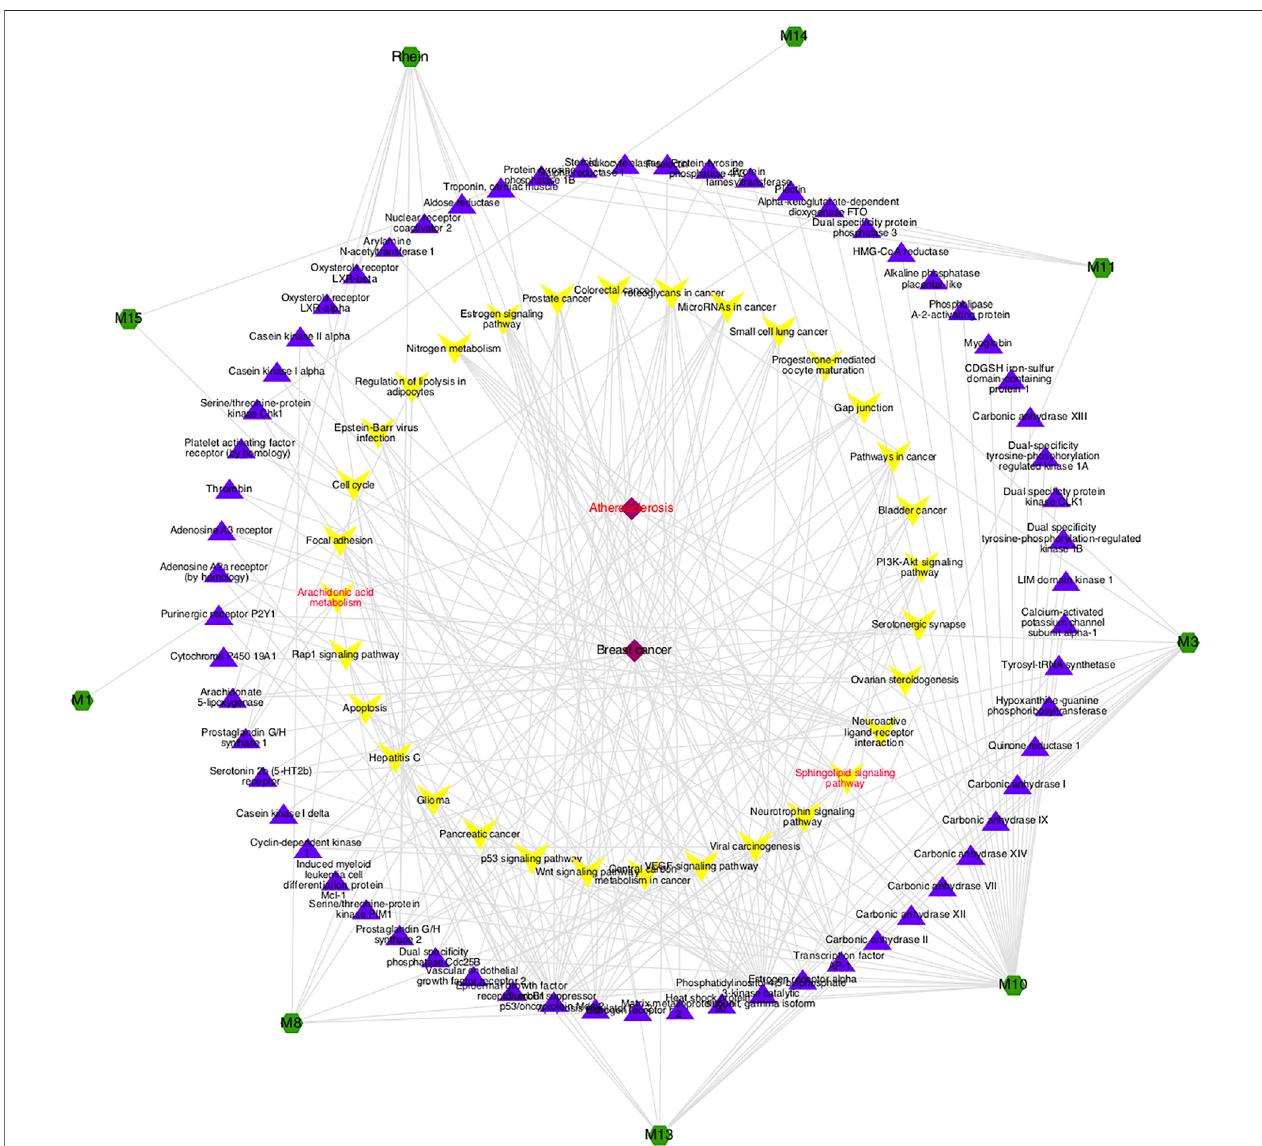
FIGURE 6 | Potential compound-target-pathway-disease network. The green nodes represent potential active components, purple nodes represent related targets, yellow nodes represent pathways, and red nodes represent predicted diseases.